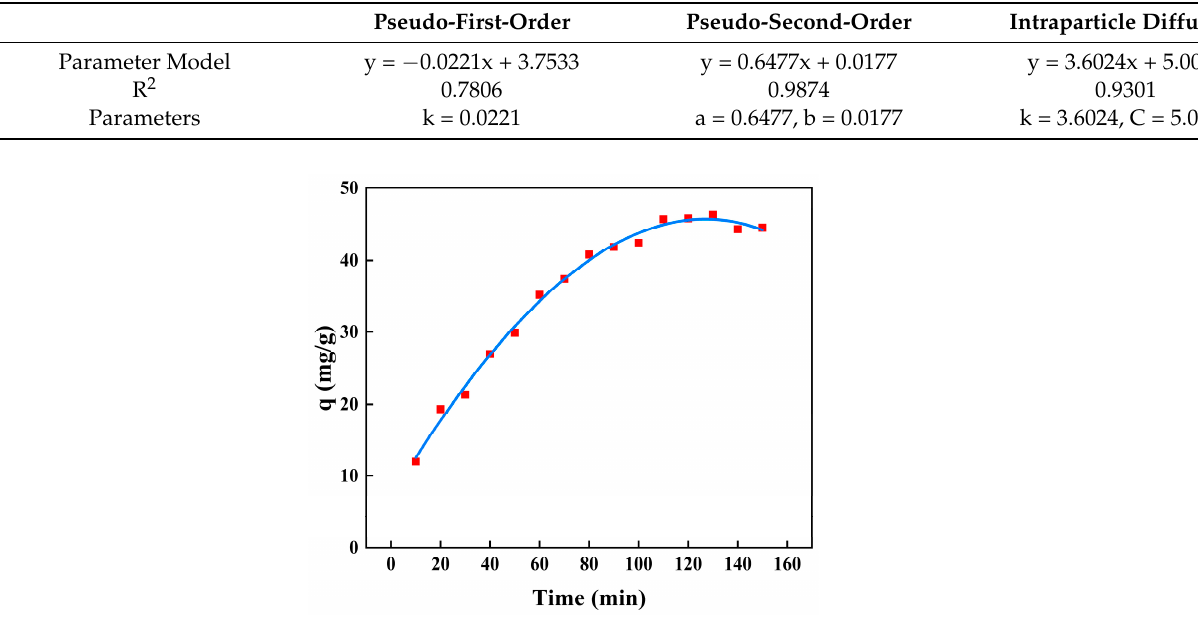
Figure 9. Nonlinear kinetics of BSA on the composite membrane.